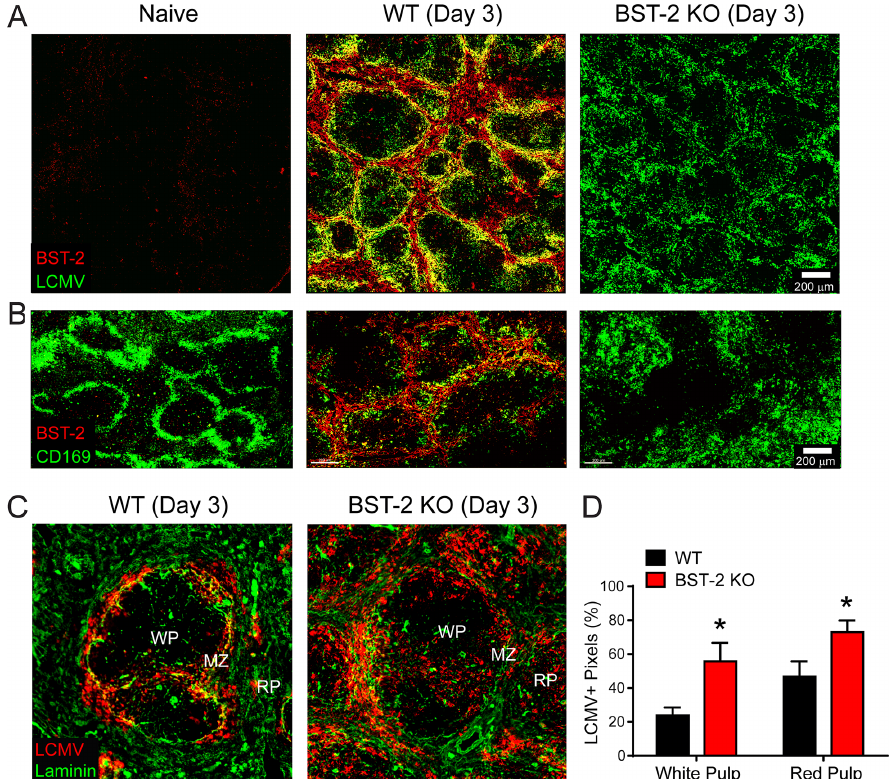
Fig 4. BST-2 contains LCMV within the splenic marginal zone. A-B. Representative confocal images from na ï ve, d3 WT, and d3 BST-2 KO mice depict the splenic distribution of LCMV Cl-13 (green; A) or CD169+ metallophillic macrophages (green; B) in relation to BST-2 expression (red) (n = 4 mice per group; 2 independent experiments). C. Representative confocal images captured in the spleens of WT vs. BST-2 KO mice at day 3 post-infection show the distribution of LCMV (red) in relation to the white pulp (WP), marginal zone (MZ), and red pulp (RP). Laminin staining is shown in green to delineate these anatomical regions. D. Quantification of the LCMV staining pattern shown in panel C (n = 8 mice per group; 2 independent experiments). Data are represented as mean ± SD. Asterisks denote statistical significance ( (cid:3) P <